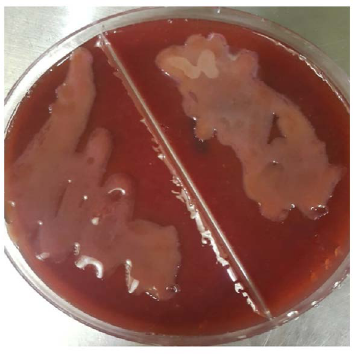
Fig. 1. Pale pink mucoid colonies of Klebsiella on MacConkey agar